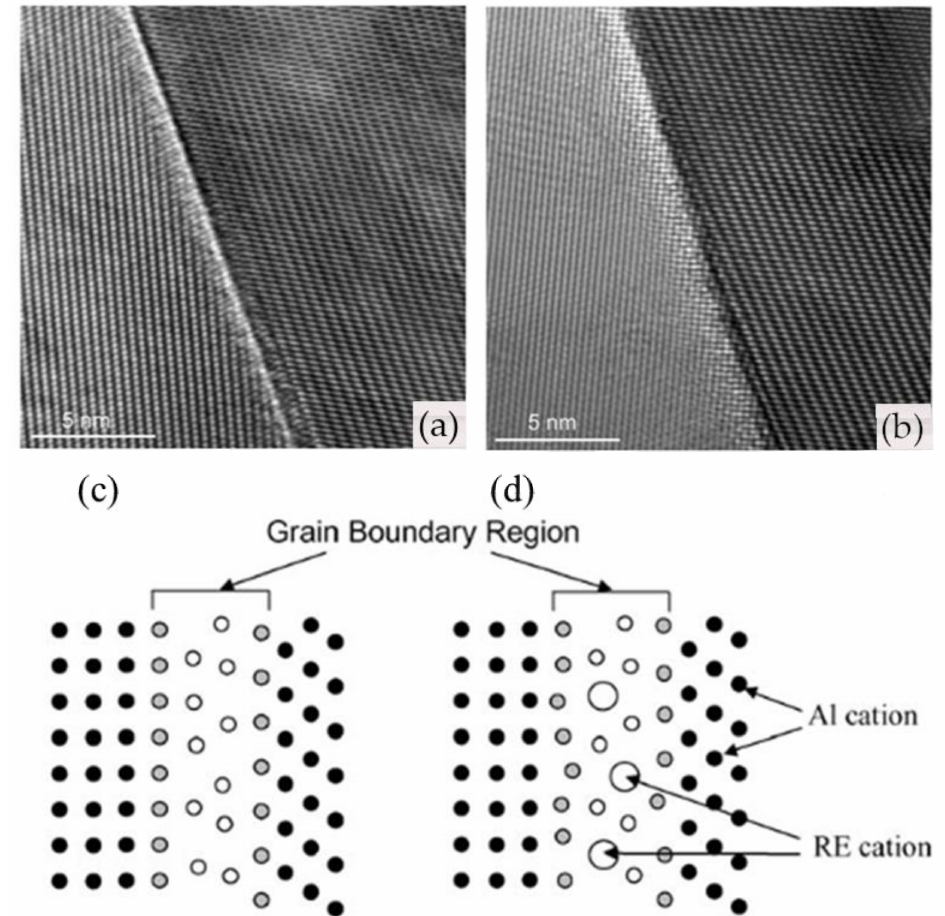
Figure 24. HRTEM micrographs of ( a ) un-doped and ( b ) La-doped alumina GBs viewed edge on. Schematic models of ( c ) un-doped and ( d ) RE doped GB in alumina [195]. Note the wider GB region in RE doped alumina shown in ( b , d ). Figure 24 reprinted by permission from Springer Nature Customer Service Centre GmbH: Springer Nature, Journal of Materials Science, Characterisation of fine-grained oxide ceramics, West, G.D.; Perkins, J.M.; Lewis, M.H., Copyright ©